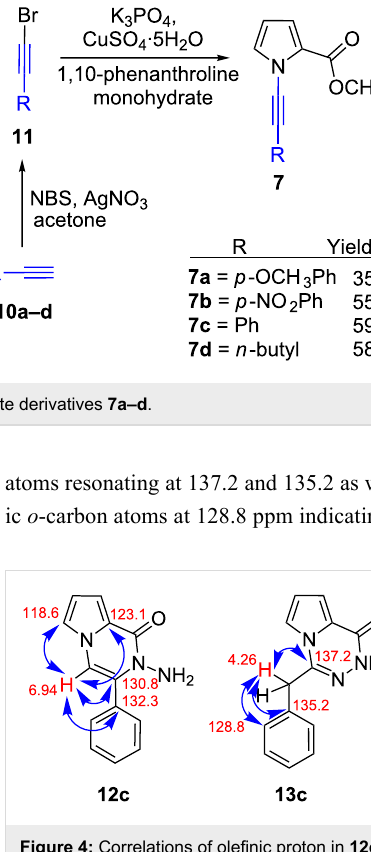
Figure 4: Correlations of olefinic proton in 12c and methylene protons in 13c and 16 with the relevant carbon atoms (from the HMBC spec-